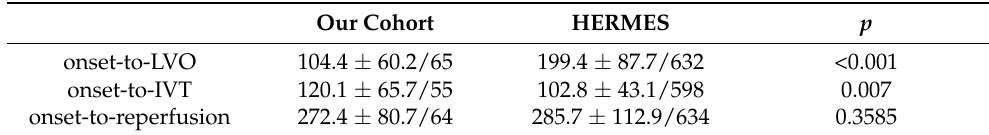
Table 2. Process times comparison (three wake-up stroke patients’ data excluded, two patients with missing data excluded). Data are presented as mean ± SD/N.